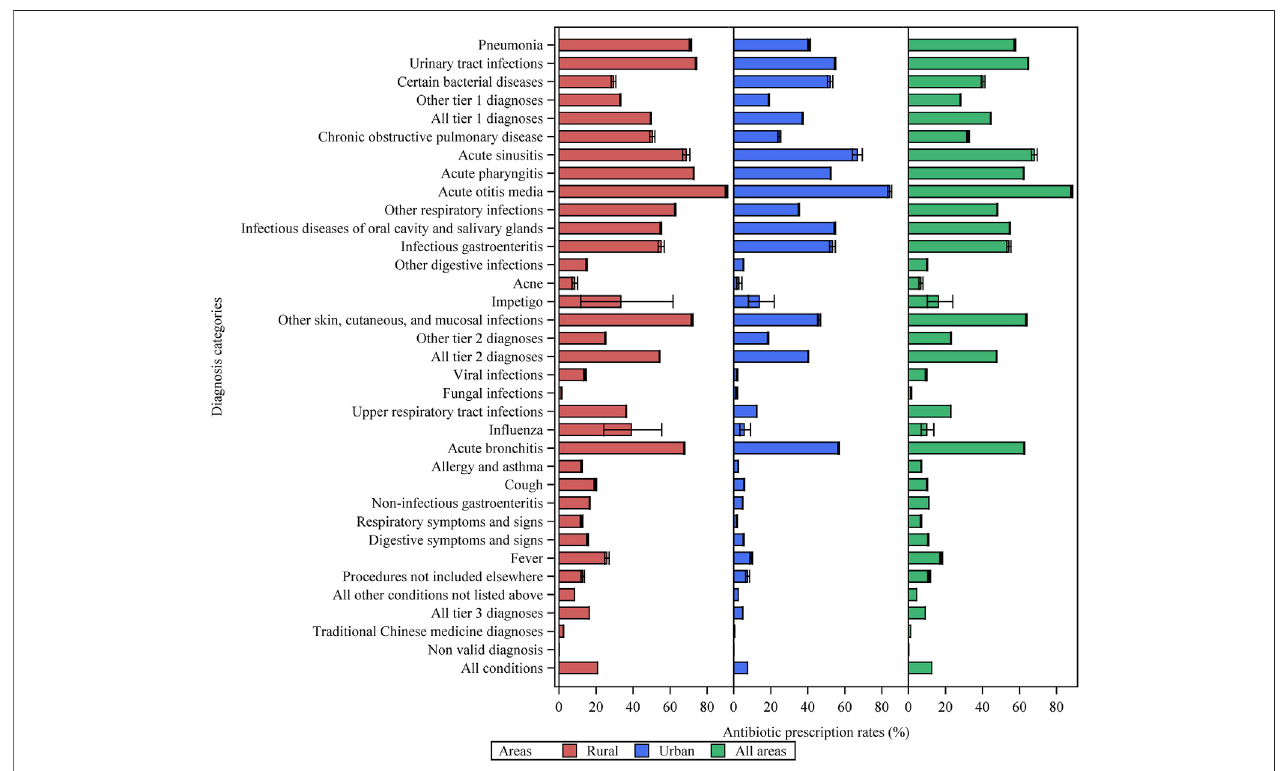
FIGURE1| AntibioticprescriptionratesforvariousdiagnosticcategoriesofpatientvisitsinprimarycaresettingsinYinchuanCity.Othertier1diagnoses=othertier 1bacterialinfections.Otherrespiratoryinfections=otherinfectiousdiseasesoftherespiratorysystemcategorizedintier2.Othertier2diagnoses=othertier2infectious diseases for which an antibiotic may be